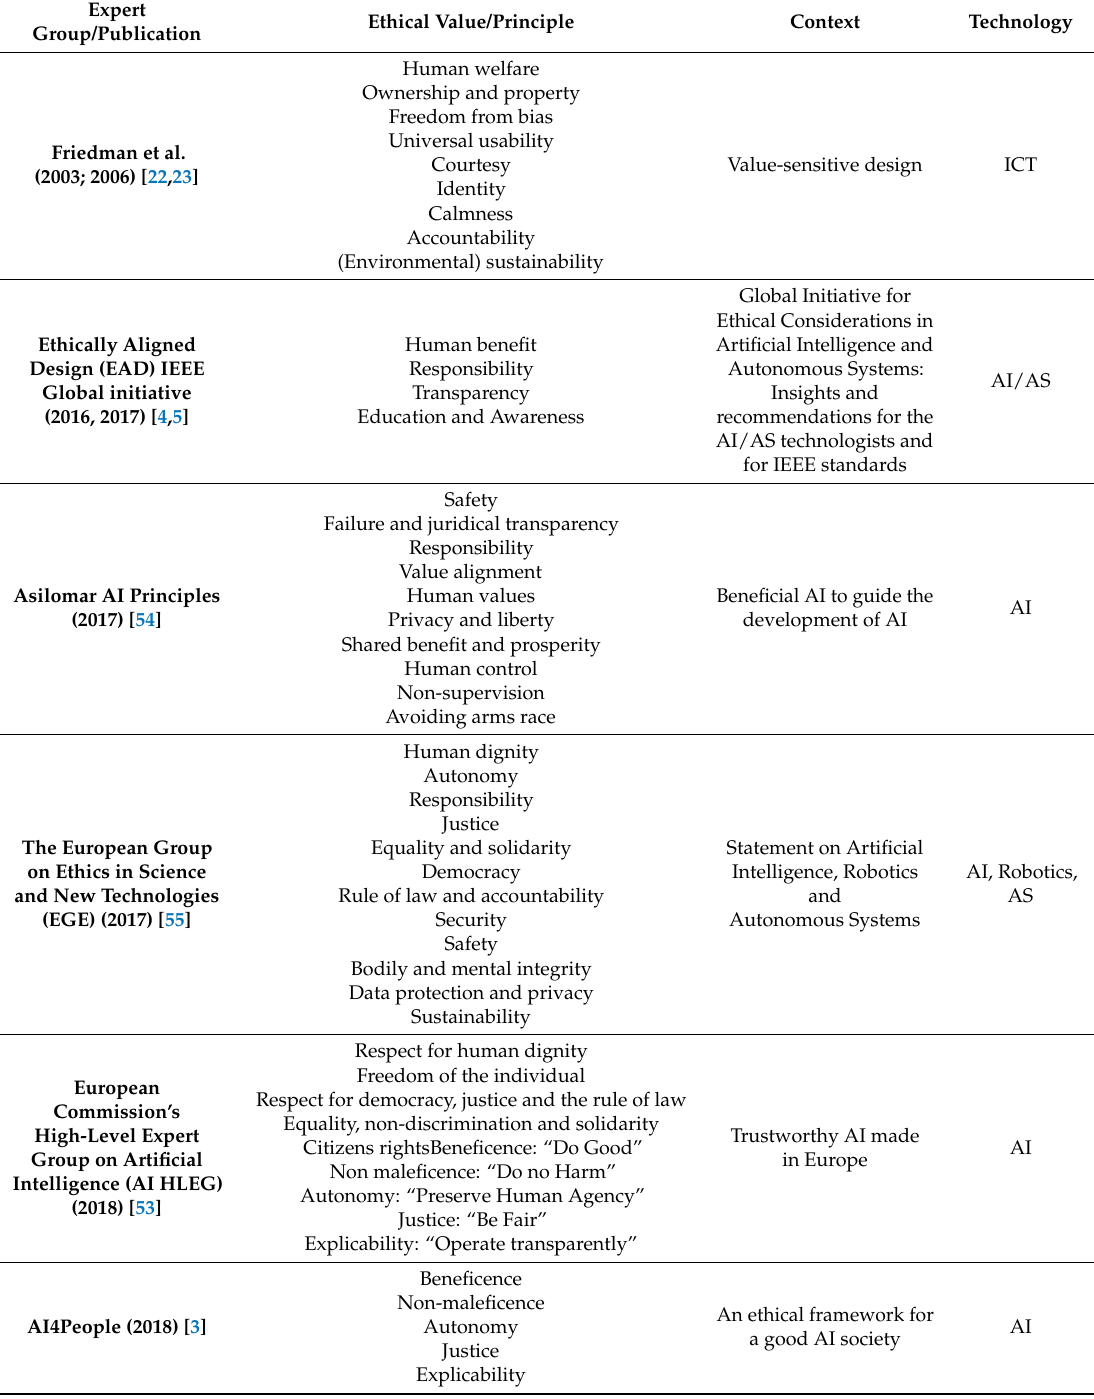
Table 1. Ethical values and principles in European discussion of technology